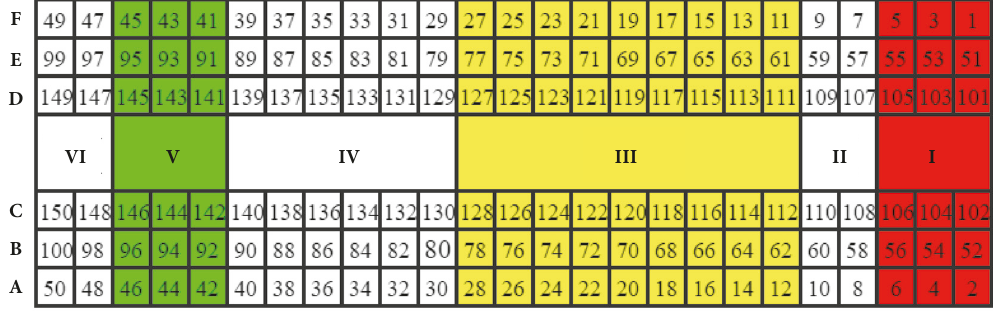
Figure 4: The seat assignment rules in the